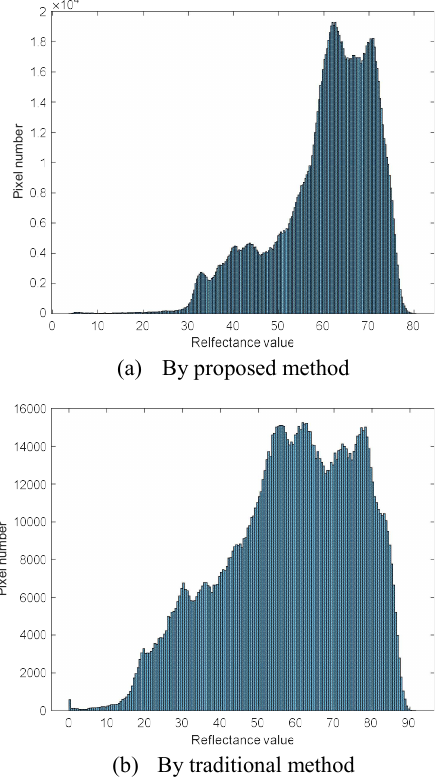
Figure 6. The histogram of 440 th band (644